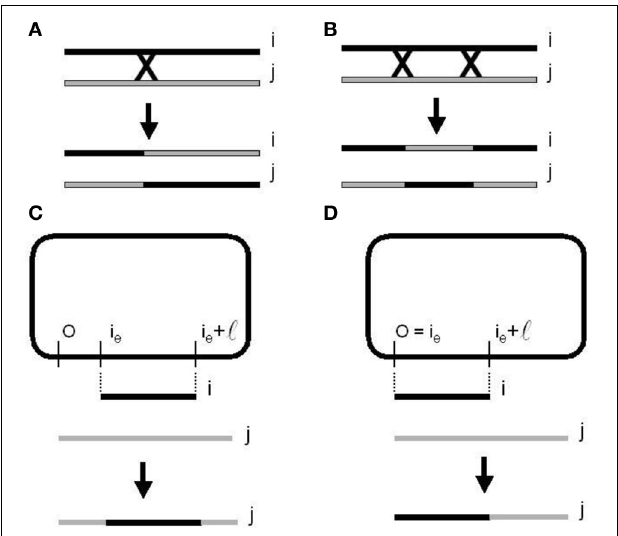
FIGURE 6 | Homologous recombination or cross over mechanisms. (A) One-point re-combination. (B) Two-points recombination. Bacterial conjugation and recombination. (C) With a random point (CORP). (D) With a fixed point (COFP) on the donor chromosome (Perales-Graván and Lahoz-Beltra,